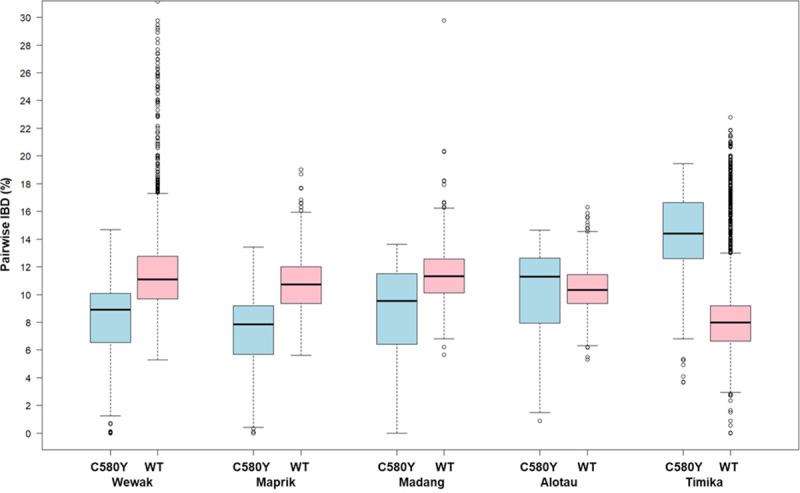
IBD between parasites from Wewak and those from other New Guinea sites.This plot shows the distributions of the level of IBD (i.e. the percentage of the genome that is predicted to be in IBD) between parasites samples in Wewak and those sampled at other sites on the island of New Guinea. For each of the five sites, two boxplots show the distribution of pairwise IBD levels for parasites from that site: either against the Wewak C580Y mutants (blue, labelled “C580Y”), or against the Wewak kelch13 wild-type parasites (pink, “WT”). For the Wewak site (first two boxplots) we compare the two groups against Wewak WT samples only; hence, the blue boxplot shows IBD levels between Wewak C580Y mutants and Wewak WT parasites, while the pink boxplot shows IBD levels among Wewak WT parasites only.